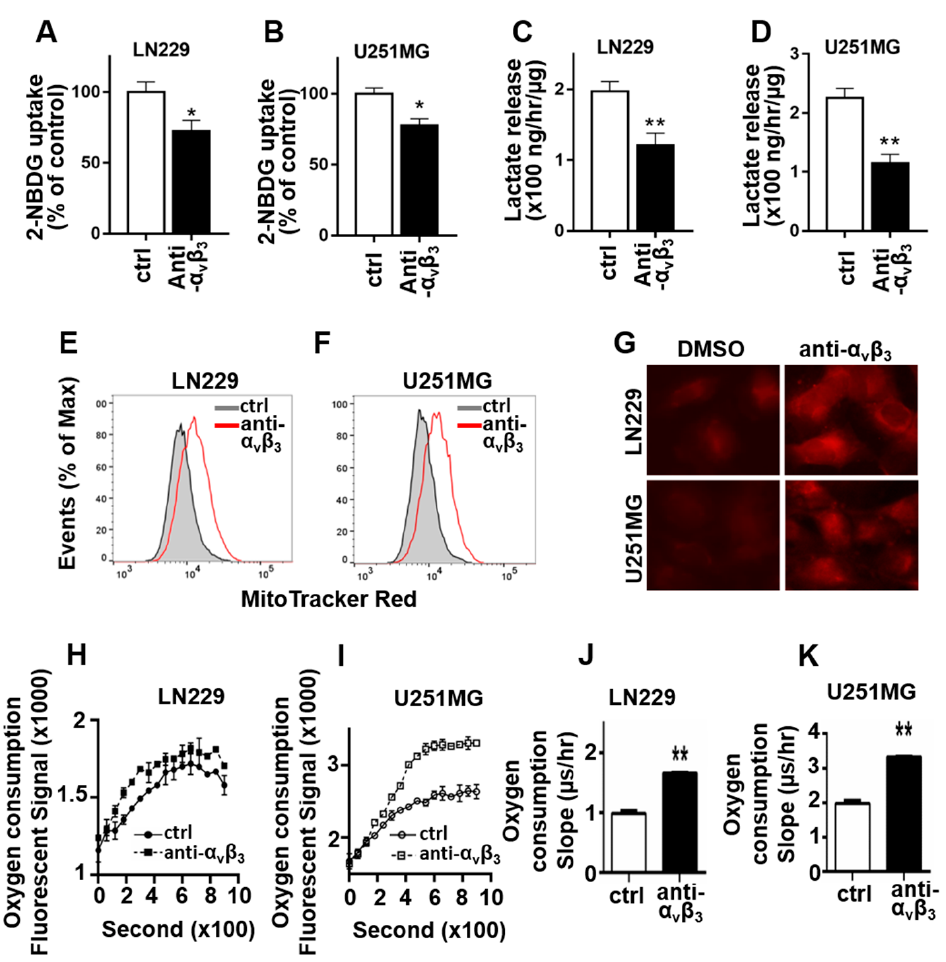
Figure 2. Engagement of integrin α v β 3 with osteopontin promotes glucose uptake and lactate production but inhibits mitochondria function and O 2 consumption in LN229 and U251MG. ( A , B ) Uptake of glucose analog 2-NBDG was reduced in cells treated α v β 3 blocking antibody when compared to cells treated with control isotype antibody (ctrl). ( C , D ) Lactate in culture medium was decreased in cells treated with α v β 3 blocking antibody. ( E , F ) Flow cytometry analysis of MitoTracker stained cells showed an increase in mitochondrial function in cells treated with α v β 3 blocking antibody. ( G ) Representative immunofluorescent images of the MitoTracker labeled cells with α v β 3 or control antibody (400×). Stronger fluorescence appeared in cells treated with α v β 3 blocking antibody. ( H , I ) Oxygen consumption curve increased in cells treated with α v β 3 blocking antibody. ( J , K ) Cellular oxygen consumption rate (slop) calculated based on the oxygen consumption curves in panels ( H , I ). All experiments were repeated at least three times. Data are represented as mean ± SE, * p < 0.05, ** p < 0.01.